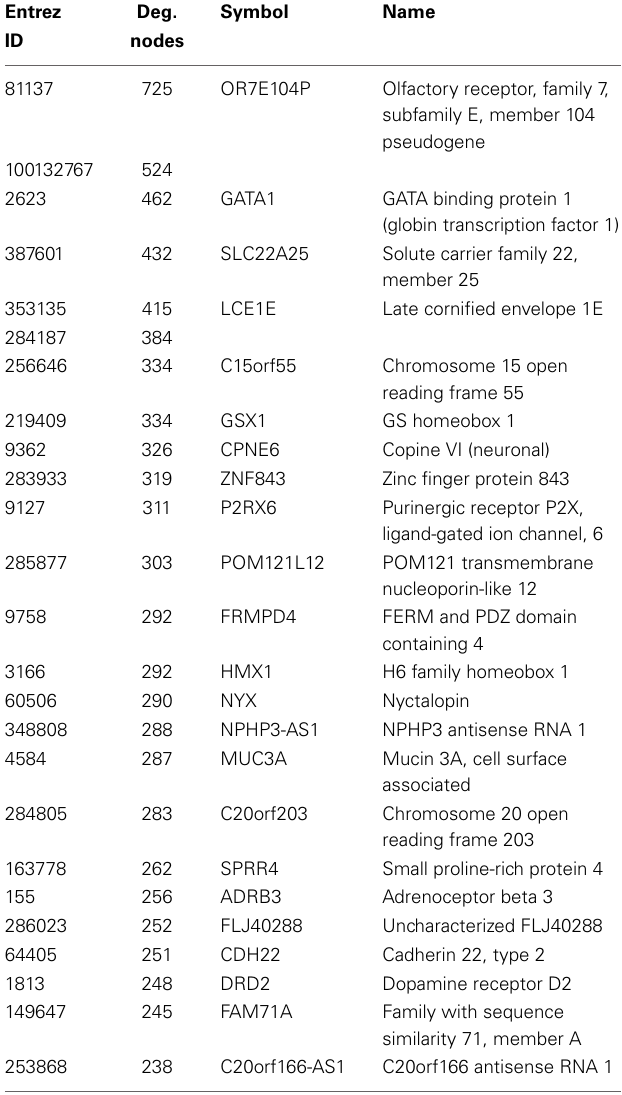
Table 4 | Census cancer genes ranked by degree in all-census-pair shortest path network. Entrez